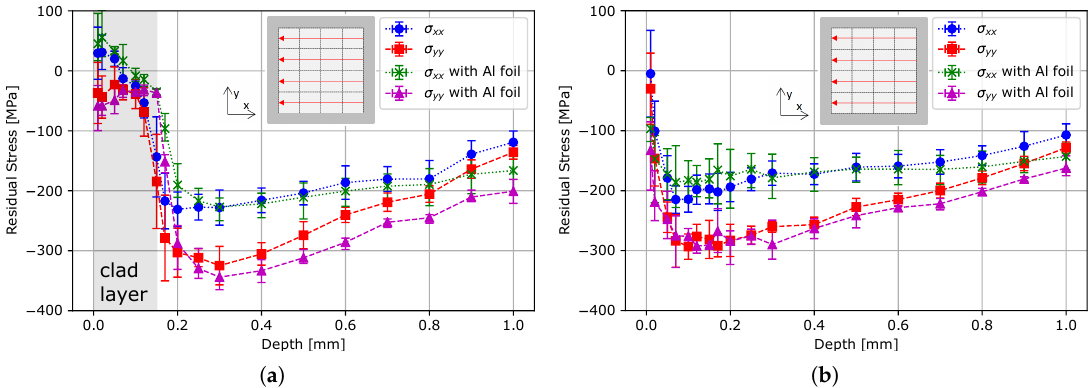
Figure 3. Laser Peening (LP) with and without Al foil: The advancing direction is chosen parallel to the rolling direction of the specimens: ( a ) AA2024-T3clad, the gray area indicates the clad layer; ( b ) AA2024-T3